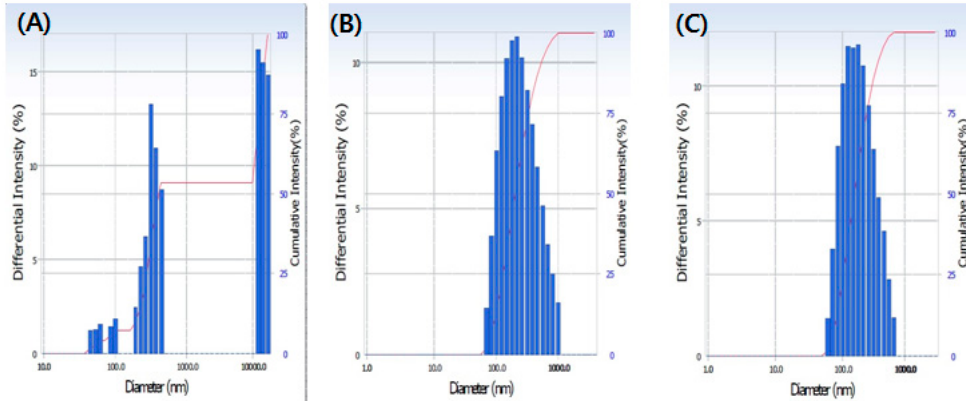
Figure 2. Particle size distribution of the soybean-polymer composite. ( A ) Non extrudate soybean; ( B ) extrudate soybean at 130 °C; ( C ) soybean (95%) + hydroxypropyl methylcellulose (HPMC) (5%) extrudate at 130 °C.